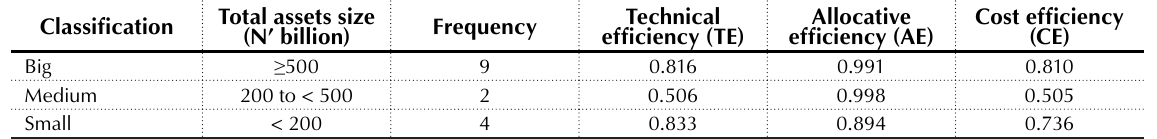
Table 11. 3-year measured mean efficiency of the deposit money banks (2006‒2008)